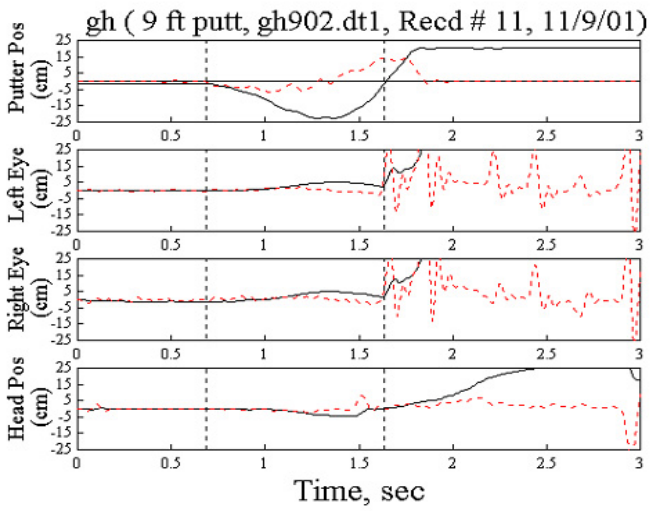
Figure 9A. Time traces of putter, eye, and head movements for a typical 9-ft putt using the conventional grip. The hole location is in the direction of the top of the page. Positive and negative numbers represent movements towards or away from the hole, respectively. Top trace - Putter position. 2nd and 3rd traces - Left and right eye positions, respectively. The eye movements, via the calibration procedure, are in the unit of cm displacement on the platform. Bottom trace - Head rotation. The angle of rotation about an imaginary axis through the top of the head and its center-of-rotation has been converted to equivalent movement of an imaginary beam projected from the center-of-rotation of the head (approximated by the center position between the two eyes) onto the platform, in cm. For all traces, the position and velocity are designated by solid and dashed lines, respectively. Vertical dashed lines were visually selected to encompass the duration of the putt from the beginning of the backstroke to the point of impact. Sub. GH.